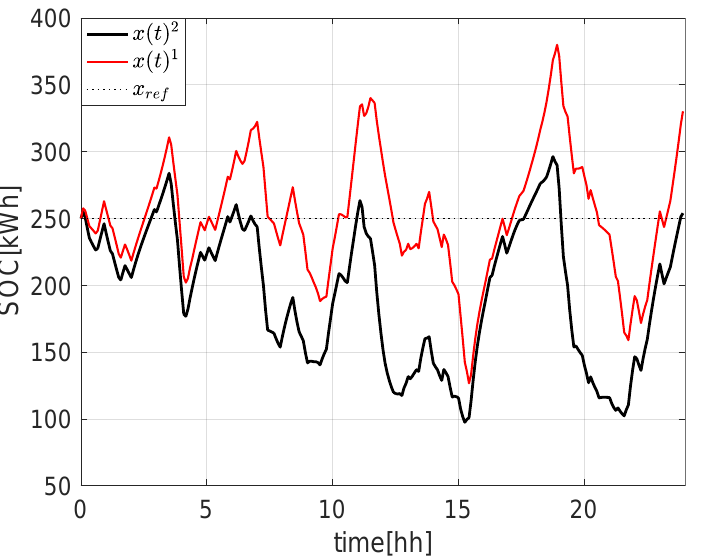
Figure 6. Power evolution at POC. p ( t ) 1 is computed with fixed c = 15; p ( t ) 2 is computed with c(t), as in (15).